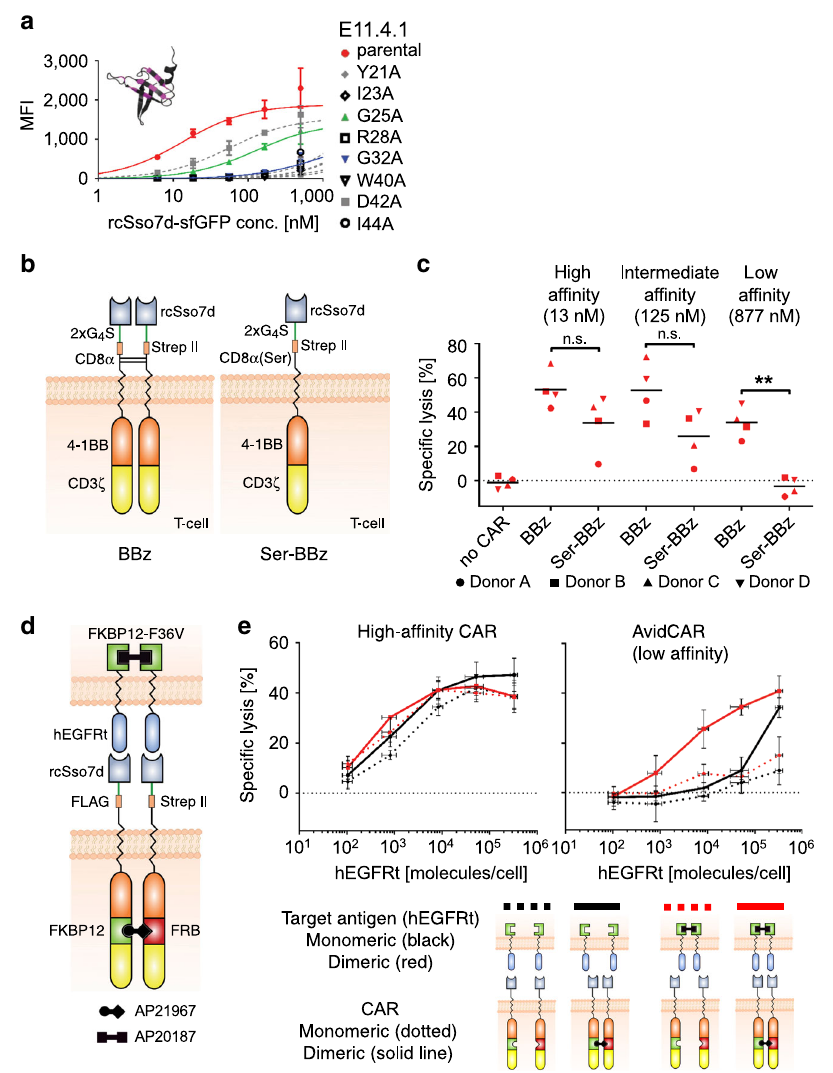
Fig. 2 Generation of AvidCARs. a Flow cytometric determination of the af fi nities of hEGFR-speci fi c binder mutants. Soluble binder proteins (sfGFP fused to E11.4.1 or mutants thereof) were titrated on hEGFRt pos Jurkat cells. Shown are the median fl uorescence intensities (MFI) of bound E11.4.1-variants (three independent experiments; mean values ± SD). Colored lines indicate the high-, intermediate-, and low-af fi nity binders used in the following experiments. The insert in the diagram shows the structure of the original Sso7d binder scaffold with its mutated binding surface in pink (PDB 1SSO). b , c Dependence of CAR function on binder af fi nity and CAR dimerization. b Schematic of the tested CARs. Selected rcSso7d-based binders were fused to a CAR backbone in which the CD8 α hinge contained either two cysteine- or two serine residues instead (see SEQ-IDs 1 and 2 in Supplementary Data 1, respectively). c The fi gure shows the cytolytic activity of mock-T cells (no CAR) and T cells expressing the monovalent (Ser-BBz) and bivalent (BBz) CARs with different af fi nities against hEGFRt pos Jurkat target cells. (Luciferase-based assay; four independent experiments with four different donors; ** p < 0.01, calculated by two-tailed paired t -test). d , e In fl uence of CAR and antigen dimerization on the activity of AvidCARs and their high-af fi nity versions. d Schematic of the experimental system for controlled dimerization of CARs (containing domains for conditional heterodimerization by the compound AP21967; see SEQ-IDs 3 and 4 in Supplementary Data 1) and for separately regulated dimerization of the antigen hEGFRt (containing a domain for conditional homodimerization by AP20187; SEQ-ID 21). e T cells, which expressed CARs with either high- or low-af fi nity binders (i.e., K d of 13 nM or 877 nM, respectively), were co- cultured with Jurkat cells expressing different levels of hEGFRt. The effect of CAR and antigen dimerization was tested by separately regulating these two dimerization events with AP21967 and AP20187, respectively. The fi gure shows the lysis of hEGFRt-expressing Jurkat cells as determined by a fl ow cytometry-based cytotoxicity assay (two independent experiments with three different donors; mean values ± SD). Exact p values are given in Supplementary Data 2. Source data are provided as a Source data fi af fi nity AvidCARs were then co-cultured ± AP21967 (for CAR suggesting that the high-af fi nity CAR was not dependent on dimerization) and ± AP20187 (for antigen dimerization) with bivalent interaction (Fig. 2e, left diagram). In contrast, the low- Jurkat target cells expressing the antigen hEGFRt at different af fi nity AvidCAR ef fi ciently triggered activation only in a dimeric densities ranging from hundreds to several hundred thousand form (Fig. 2e, right diagram, black and red solid lines), again molecules per cell (Supplementary Fig. 4a). Target cell lysis demonstrating its dependency on bivalent interaction, i.e., avidity. mediated by the high-af fi nity CAR was largely independent of the Furthermore, the antigen sensitivity of this dimeric AvidCAR was dimerization state of both the CAR and the antigen, strongly strongly increased if also the antigen was dimerized (red solid line vs.